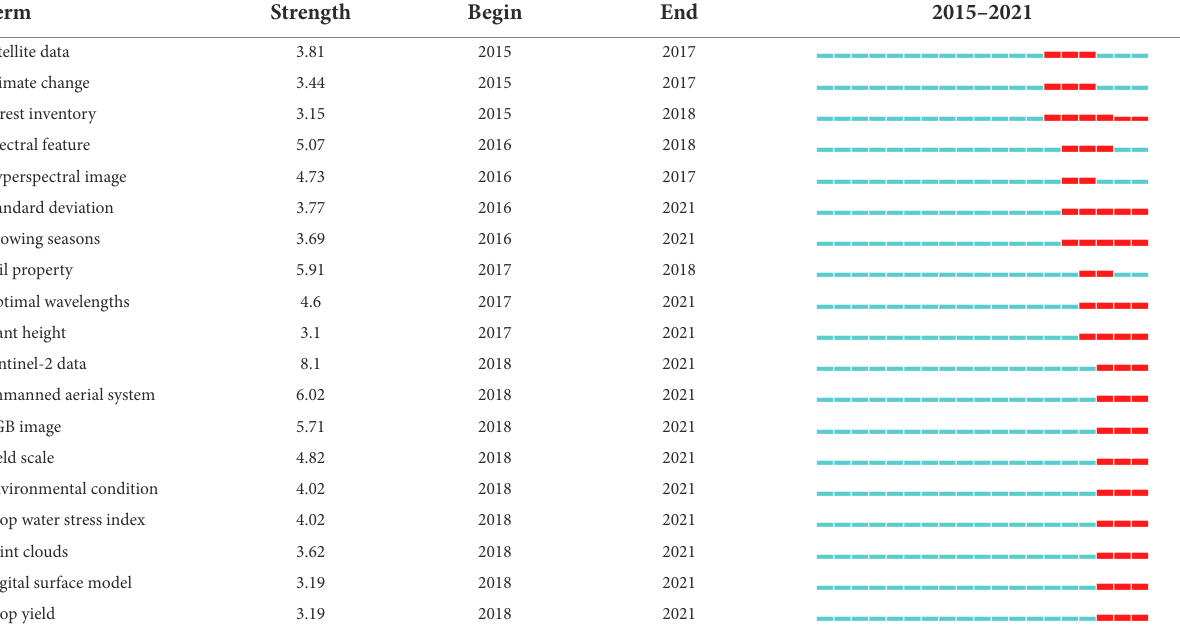
TABLE 5 Burst theme terms on agricultural multispectral study in